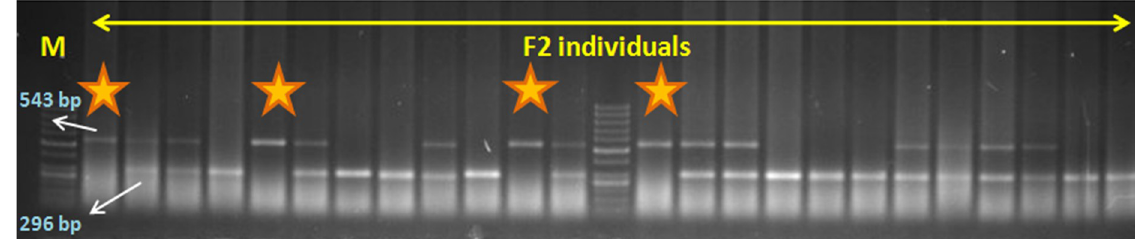
Fig 1. Segregation of favourable (543 bp) and unfavourable (296 bp) alleles of crtRB1 in F 2 populations. Star indicates favourable homozygous individuals.